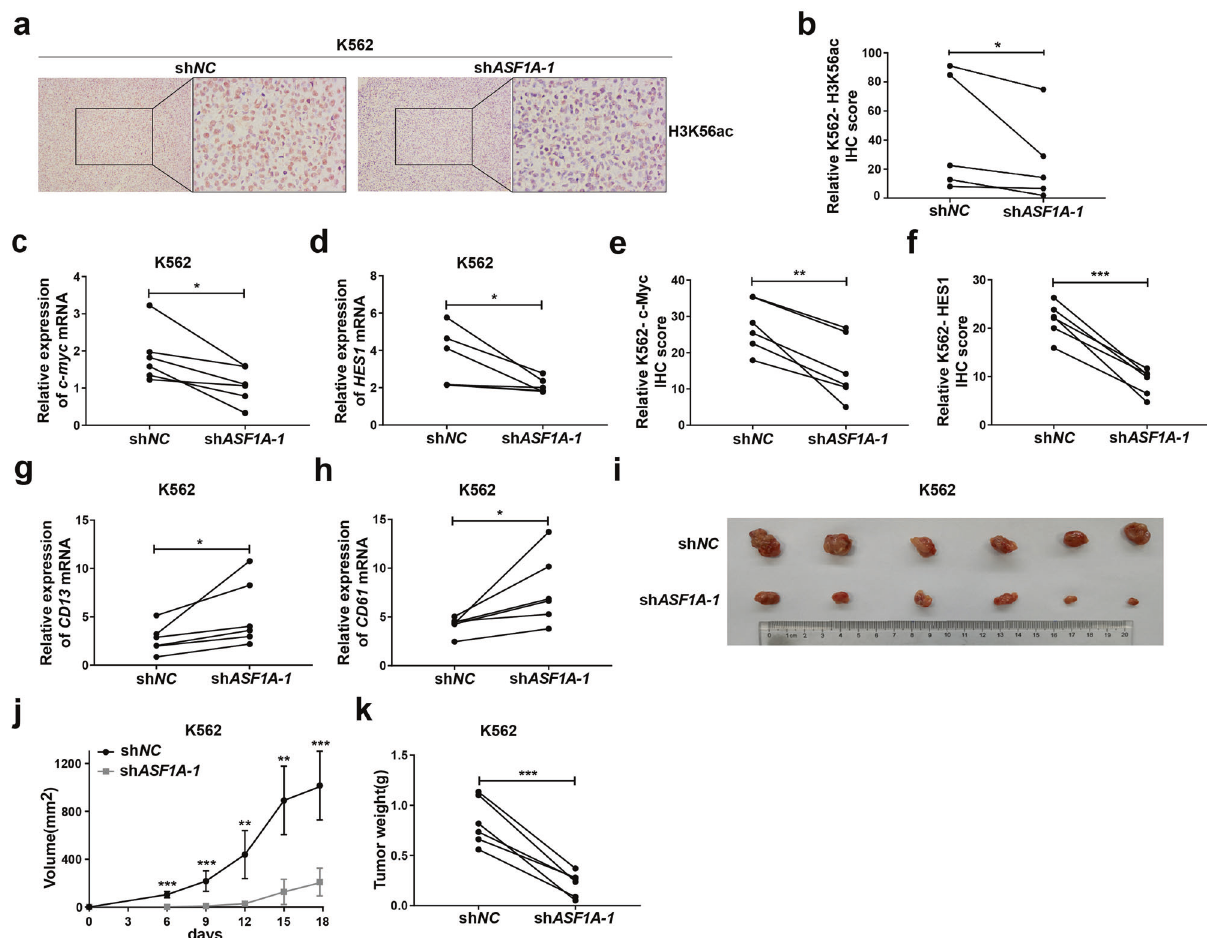
Fig. 7 ASF1A promotes the development of CML in vivo. a – h NOD-SCID mice were injected subcutaneously with K562 cells expressing empty vector (sh NC ) or sh ASF1A-1 . The protein level of H3K56Ac were analyzed by IHC ( a , b ). The mRNA and protein levels of c-Myc ( c , e ), HES1 ( d , f ), CD13 ( g ), and CD61 ( h ) were analyzed by qRT-PCR and IHC. β 2-M expression was used for normalization. i – k Primary tumor gross appearance ( i ), tumor growth curve ( j ), and tumor weight analysis ( k ) of NOD-SCID mice injected subcutaneously with K562 cells expressing empty vector (sh NC ) or sh ASF1A-1 . Statistical signi fi cance was determined by Student ’ s t test. Data are shown as mean ± standard deviation (SD). Data are presented as the mean ± SD of fi ve biologically independent animals in a , b . Data are shown as a representative result with three repeats from three independent experiments. The cell lines are applied with three independent lentiviral infections and then treated with the compounds in c – h . Data are presented as the mean ± SD of six biologically independent animals in i – k . * P < 0.05, ** P < 0.01, *** P <